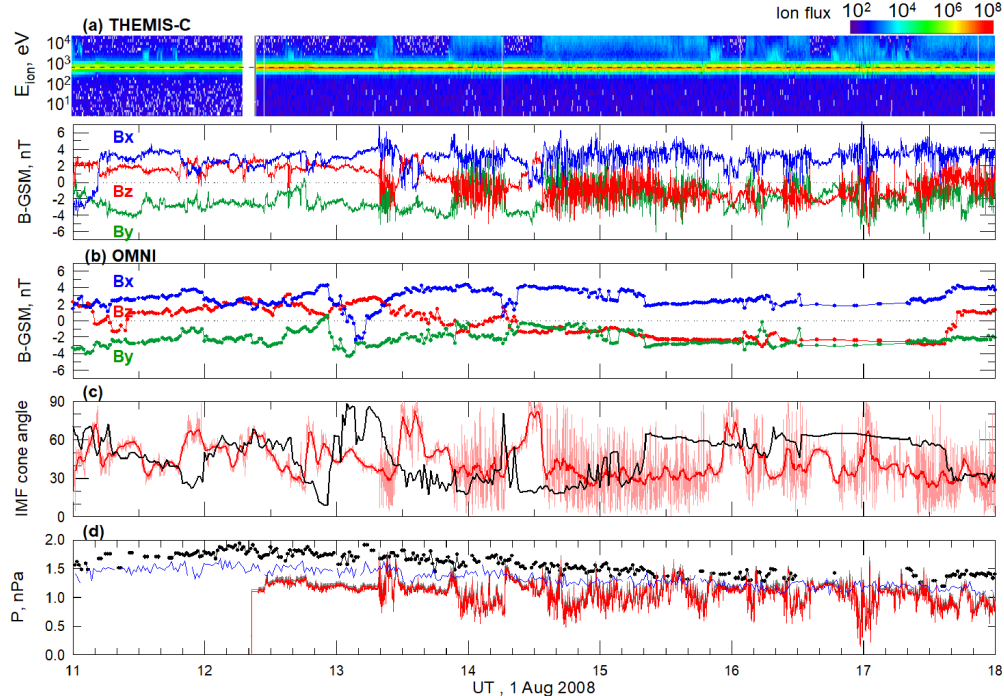
Figure 5. Observations of the plasma and magnetic field on 1 August 2008. (a) Ion spectrogram (ion flux is in units of eV(cm 2 ssreV) − 1 ) and IMF vector components in GSM coordinates measured by TH-C; (b) IMF vector components from the OMNI data set. Comparison of OMNI and TH-C data: (c) IMF cone angles plotted for OMNI (black) and TH-C (pink); the red curve shows the TH-C smoothed cone angle. (d) Solar wind dynamic pressure for OMNI (black circle), ACE (blue curve), and TH-C (red curve). The grey curve shows TH-C total pressure (sum of dynamic, magnetic, and thermal pressures). The ACE data are shifted by